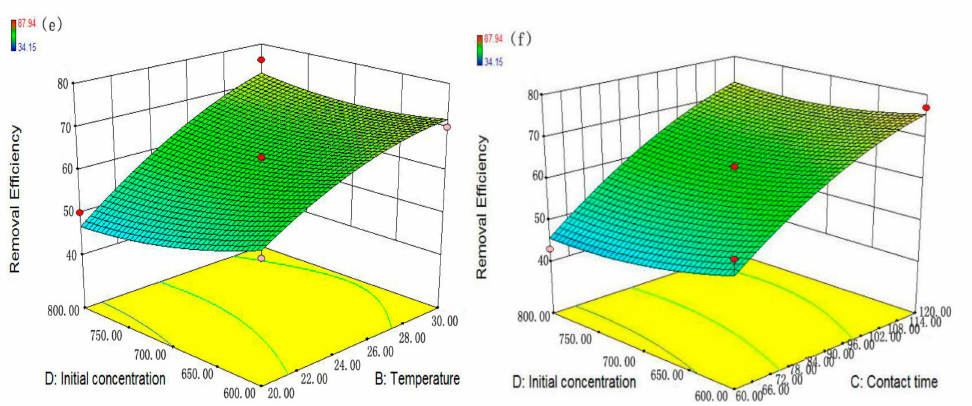
Figure 10. Three dimensional response surface plots for the malachite green (MG) removal: ( a ) Initial pH—Temperature; ( b ) Initial pH—Contact time; ( c ) Initial pH—Initial concentration ( d ) Temperature—Contact time; ( e ) Temperature—Initial concentration; ( f ) Contact time—Initial concentration.